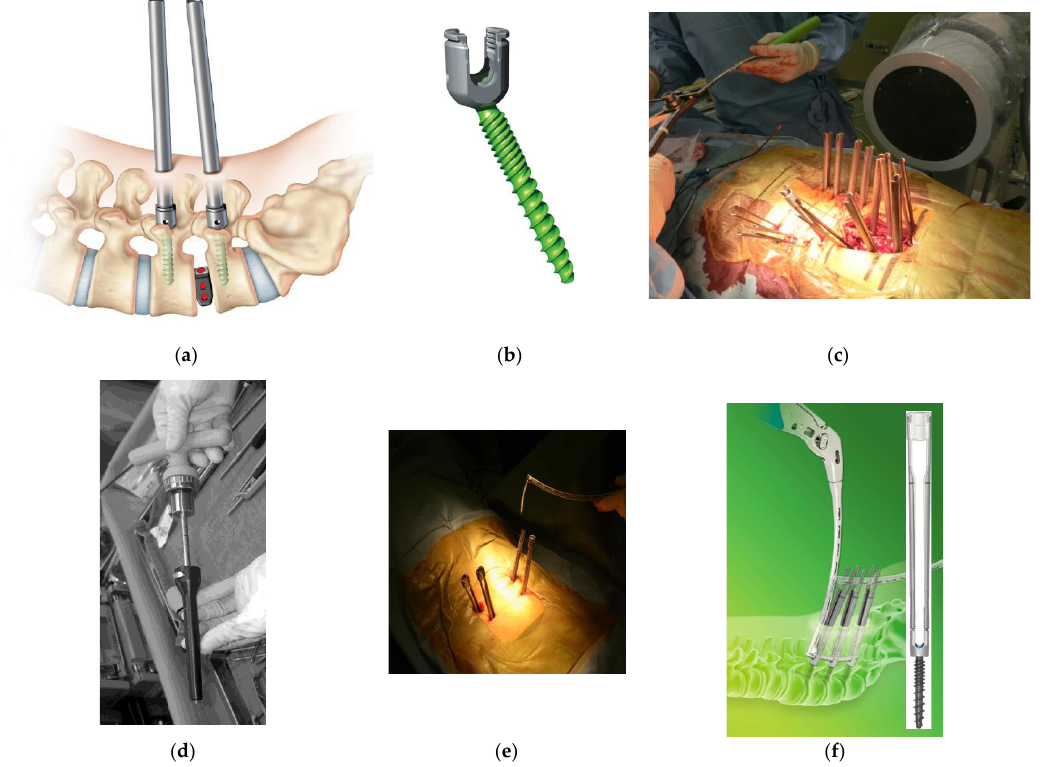
Figure 2. Third-generation PPS systems (VIPER2 X-tab ® and Voyager ® ). VIPER2 X-tab ® ( a ), VIPER2 cortical fix screw (tip is dual lead thread; base is quad lead thread) ( b ), VIPER2 X-tab ® long fixation ( c ), VIPER2 ® tap guard ( d ), and Voyager ® ( e , f ). Table 1. Commercially Available PPS Systems.